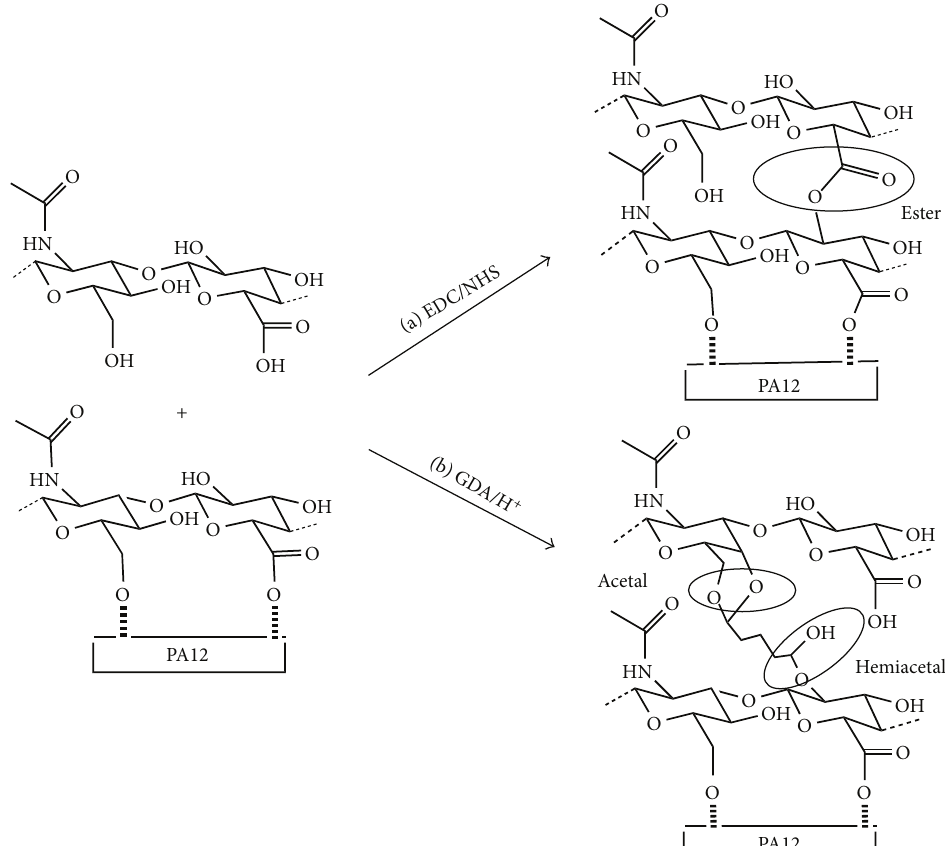
Figure 2: Reaction scheme for crosslinking the surface-bound HA base layer with further HA layers via (a) EDC/NHS under the formation of ester bonds or (b) GDA under the formation of hemiacetal or acetal